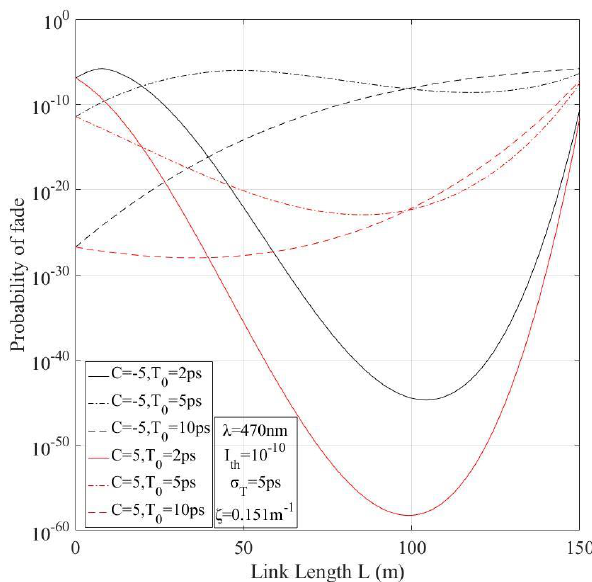
Figure 4. Probability of fade as a function of the propagation distance for various cases of input pulsewidth and chirp with fixed irradiance threshold; I th = 1 × 10 − 10 and variance σ T = 5 ps.